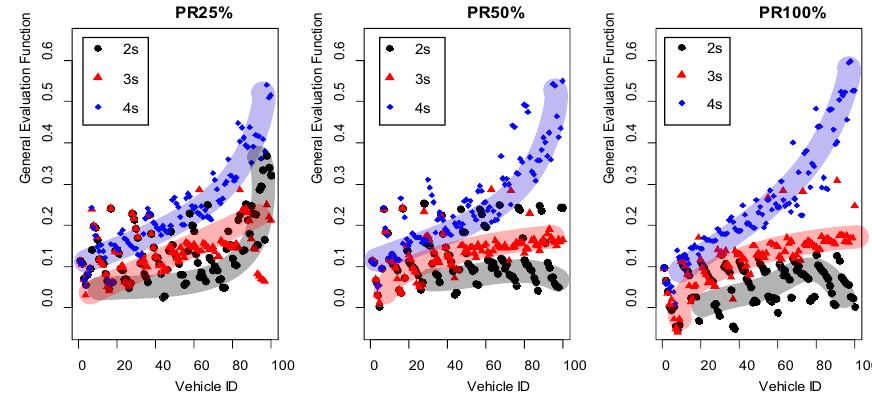
Figure 13 Diagram of GEF value with block interval of 2s, 3s and 4s corresponding to different